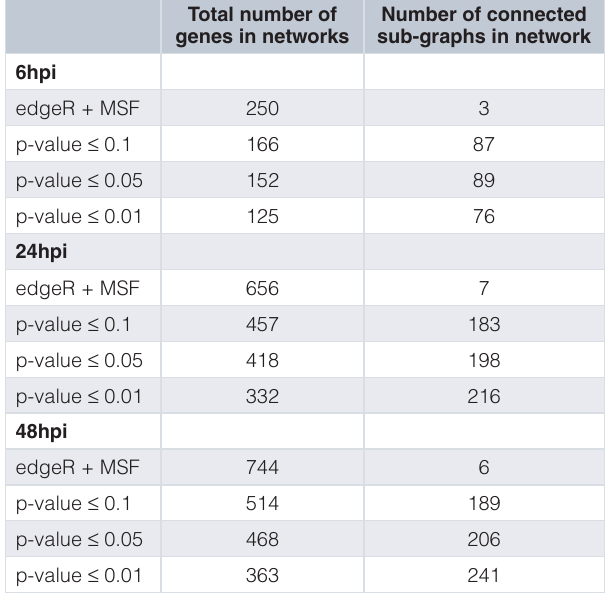
Table 1. Comparison of connected sub-graphs of modulated genes in the global network identified after the analysis with MSF and applying different p -value cut-offs from edgeR to genes in MSF identified modulated